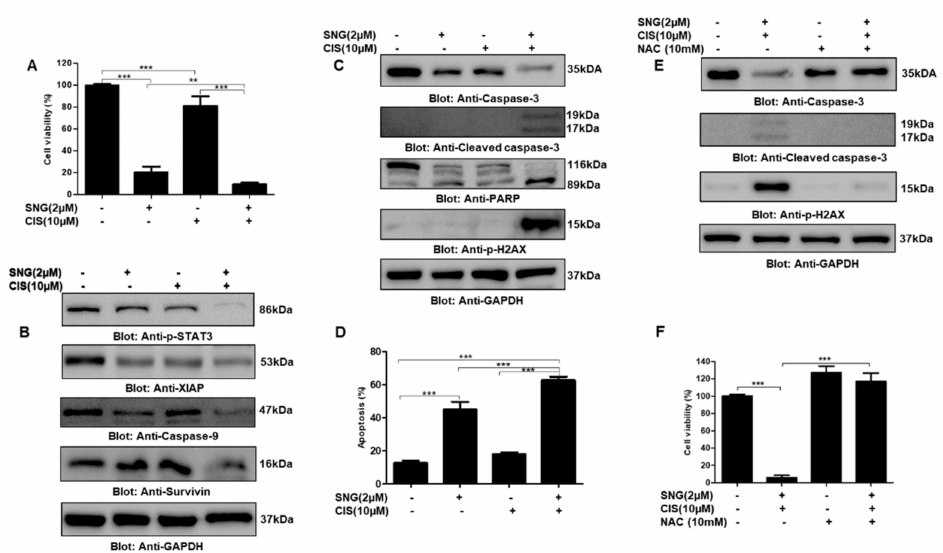
Figure 7. Sanguinarine sensitized PTC cells to anticancer drug cisplatin. ( A ) TPC-1 cells were treated with 2 µ M SNG and 10 µ M of cisplatin alone and in combination for 24h. CCK-8 was used to determine cell viability, as described in materials and methods. Values are expressed as the mean +/ − SD (standard deviation) of at least six replicates with p value ** p < 0.01, *** p < 0.001 ( n = 6). ( B , C ) The combination of SNG and cisplatin inhibits STAT3 phosphorylation and induces apoptosis: TPC-1 cells were treated with 2 µ M SNG and 10 µ M of cisplatin alone and in combination for 24 h, cells were lysed and separated by SDS-PAGE, transferred to a PVDF membrane, and immunoblotted with antibodies against p-STAT3, XIAP, caspase-9, survivin, caspase-3, cleaved caspase-3, PARP, p-H2AX and GAPDH. ( D ) SNG and cisplatin augmented apoptosis in PTC cells: TPC-1 cells were treated with 2 µ M SNG and 10 µ M, alone and in combination, for 24 h and processed using annexin V and dead cell kit, according to the manufacturer’s instructions and analyzed by Muse ® cell analyzer, as described in materials and methods. The graph displays the mean ± SD (standard deviation) p < 0.001 ( n = 3). ROS plays an important role in SNG-mediated sensitization of PTC cells to cisplatin: ( E ) TPC-1 cells were treated with 10 mM NAC, 2 µ M SNG and 10 µ M of cisplatin, alone and in combination as indicated, for 24 h. Cells were lysed, and proteins were separated on SDS-PAGE, transferred to a PVDF membrane, and immunoblotted with antibodies against caspase-3, cleaved caspase-3, p-H2AX and GAPDH. ( F ) TPC-1 cells were treated with 10 mM NAC, 2 µ M SNG and 10 µ M of cisplatin, alone and in combination as indicated, for 24 h. CCK-8 was used to determine cell viability, as described in materials and methods. Values are expressed as the mean +/ − SD (standard deviation) of at least six replicates ( n = 6). *** p <